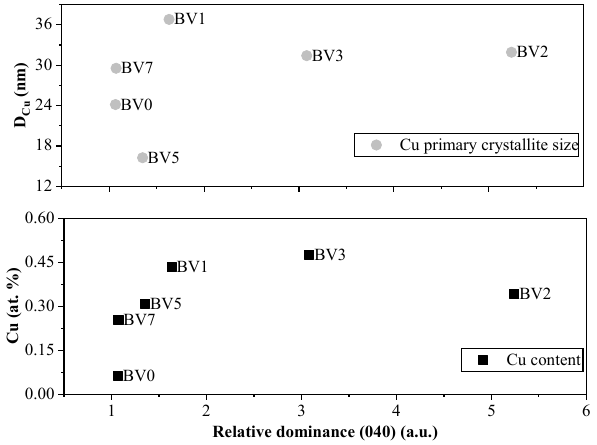
Figure 7. The dependence of the Cu deposition process on the surface of BiVO 4 . As the dominance of (040) increases so does the deposited amount of Cu and the Cu primary crystallite size as well.